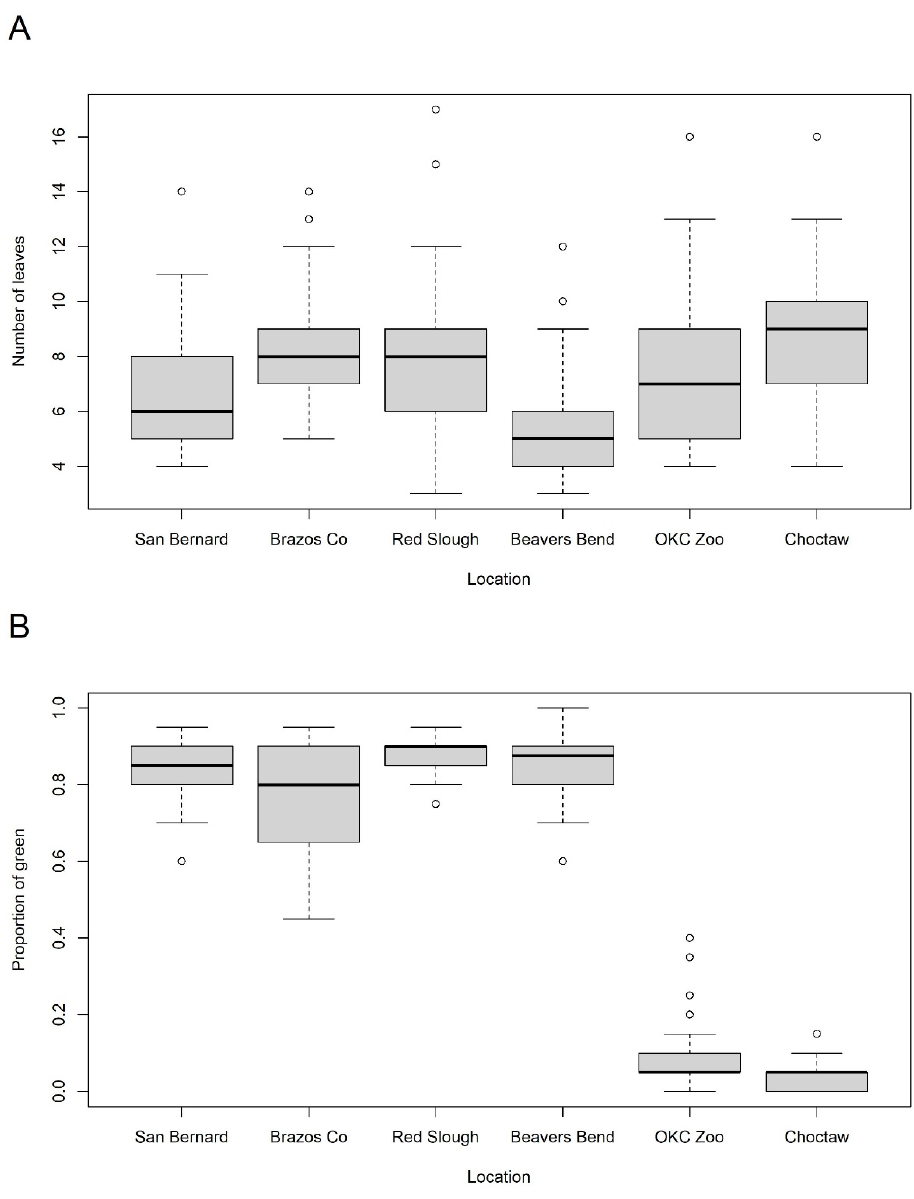
browning consistent with cold damage, but the extent of this was not quantified. Seedlings at other locations did not appear to have been damaged by arctic outbreak.